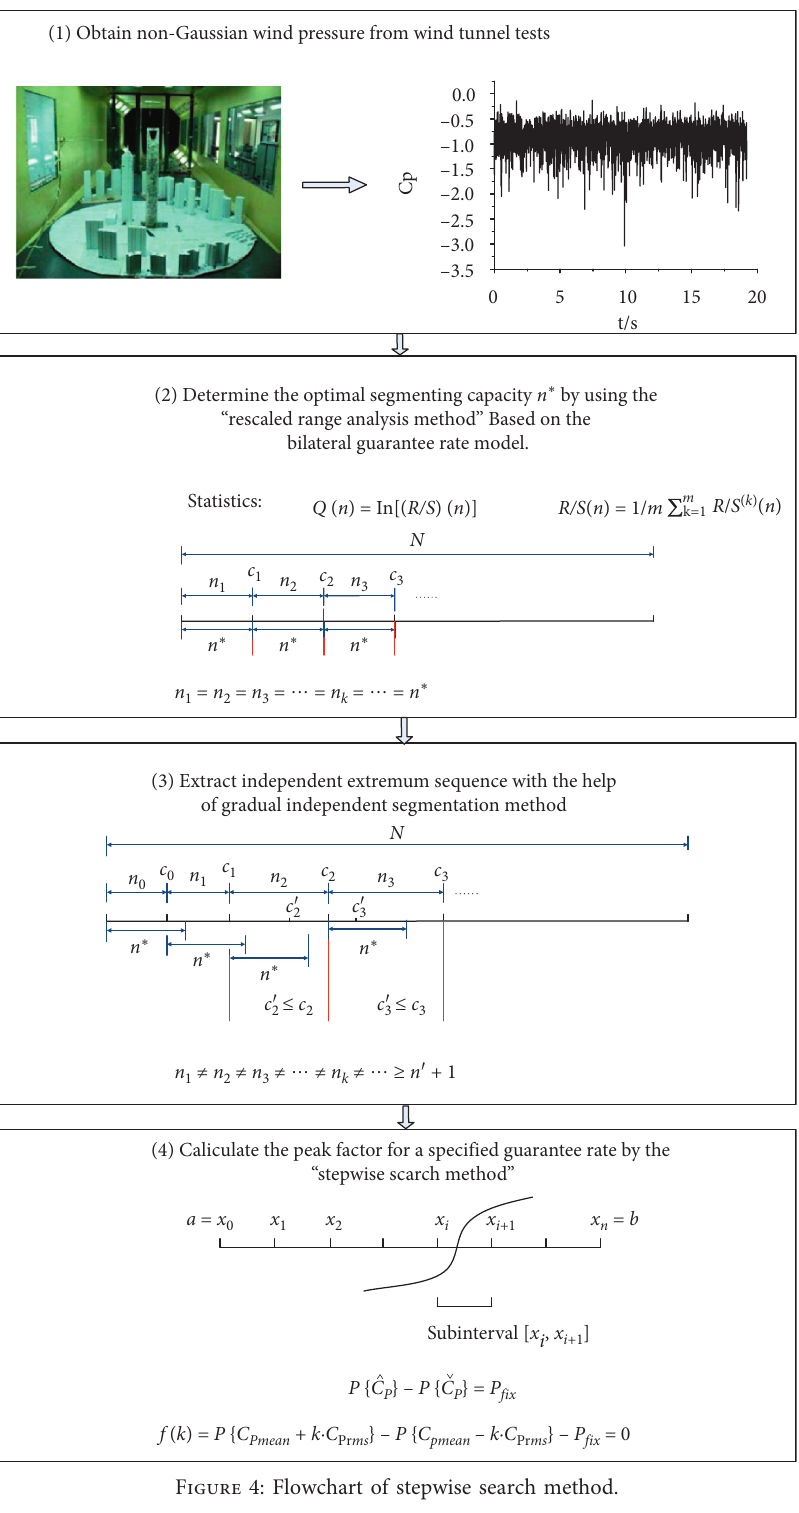
Figure 4: Flowchart of stepwise search